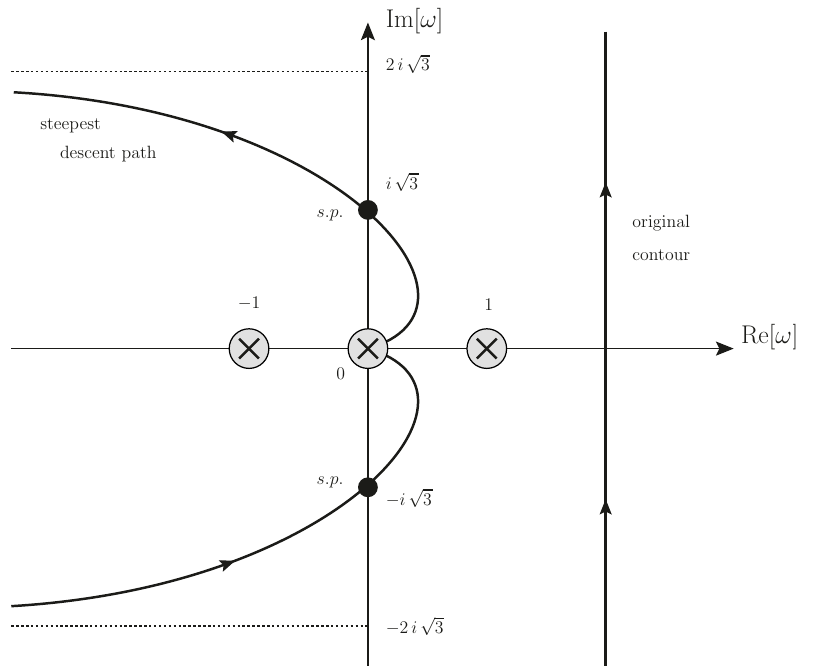
Figure 11. The complex plane structure of the ω -integral in eq. (3.84a). The singularities are denoted by circled crosses: the poles at ω = ± 1 and the essential singularity at ω = 0 . The original contour is denoted by the vertical solid straight line to the right of all the singularities. The saddle √ points at ω = ± i 3 are marked by the thick dots, while the steepest descent path is sketched by s.p. a curved solid line crossing the saddle points and going through the origin. The dashed horizontal lines denote the asymptotics of the steepest descent